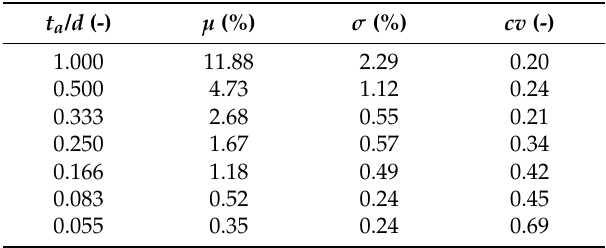
Table 5. Observed behavior of the parameters µ , σ , and cv (= σ / µ ) of Equation (9) as a function of the ratio t a / d where t a is the time resolution of rainfall data and d is the duration. t a / d (-) µ (%) σ